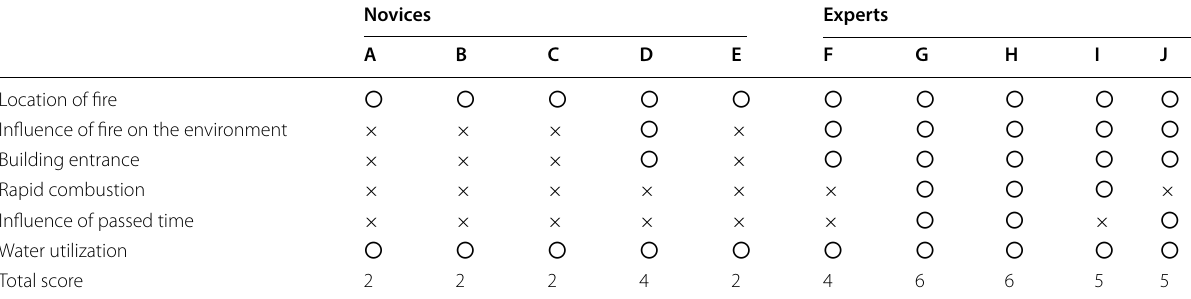
Table 11 Result of the evaluation items for reconnaissance activity Novices Experts